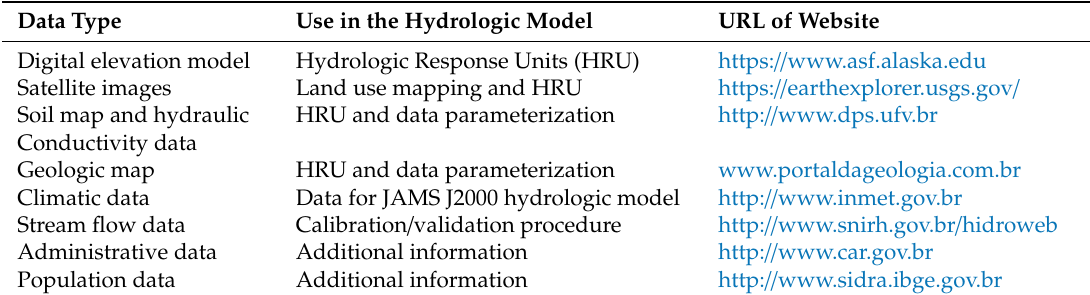
Table 1. Materials used in the JAMS J2000 hydrologic model, namely spatial data and climatic and stream flow records, and URLs of websites used for downloading the data.